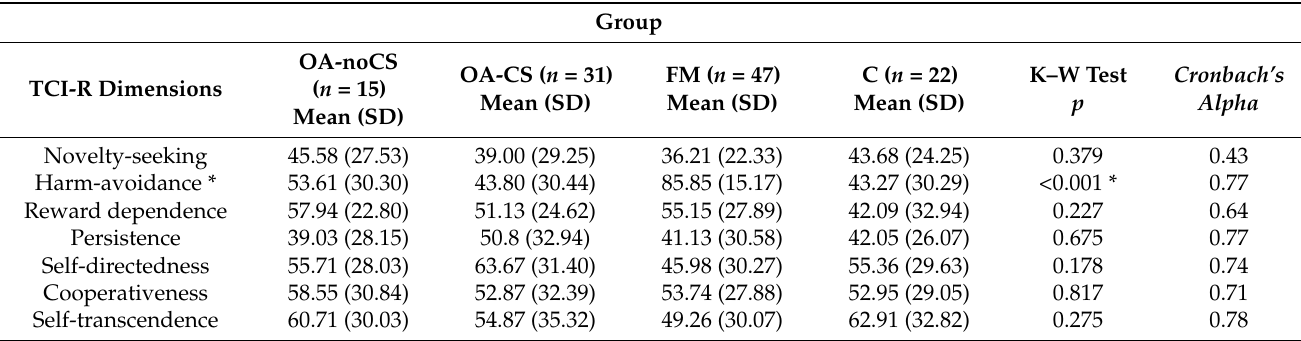
Table 2. Percentile scores of temperament and character dimensions of TCI-R by